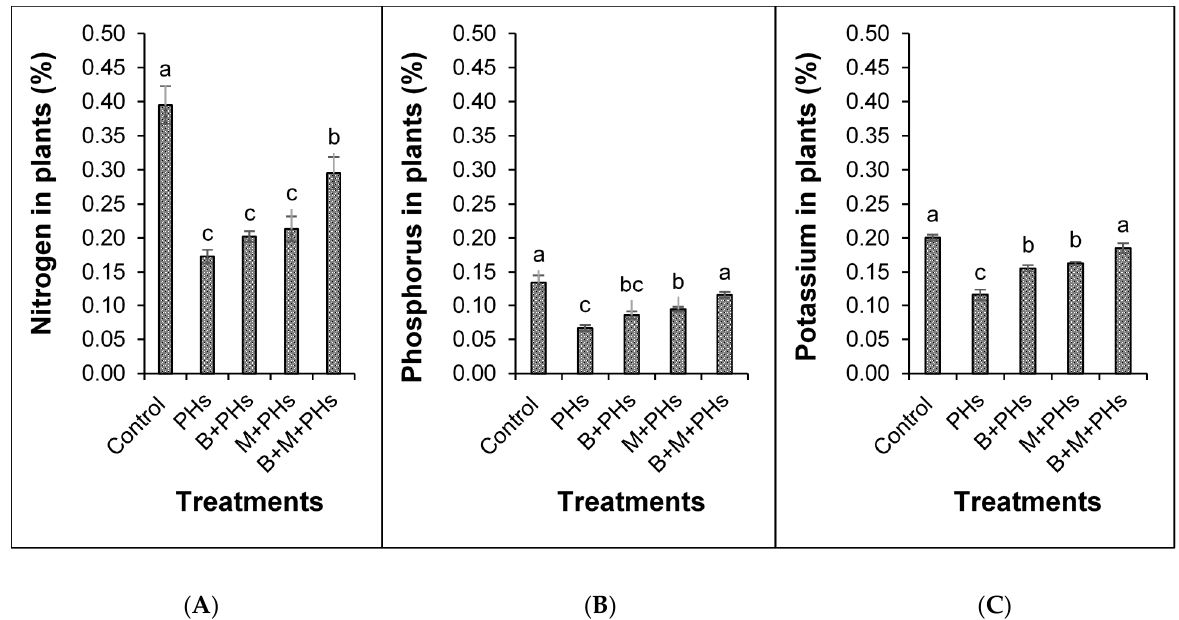
Figure 1. Effect of biochar and Bacillus sp. MN54 on nitrogen ( A ), phosphorus ( B ) and potassium ( C ) contents in plants grown on diesel contaminated soil. Columns and bars represent means and standard errors, respectively of three replicates. Means with different letters are significantly different at p ≤ 0.05 according to LSD test. (Control, Plants with uncontaminated soil; PHs + P, Plants with contaminated; B + PHs + P, Plants with contaminated soil and biochar; M + PHs + P, Plants with contaminated soil and Bacillus sp. MN54; B + M + PHs + P, Plants with contaminated soil, biochar and Bacillus sp. MN54).